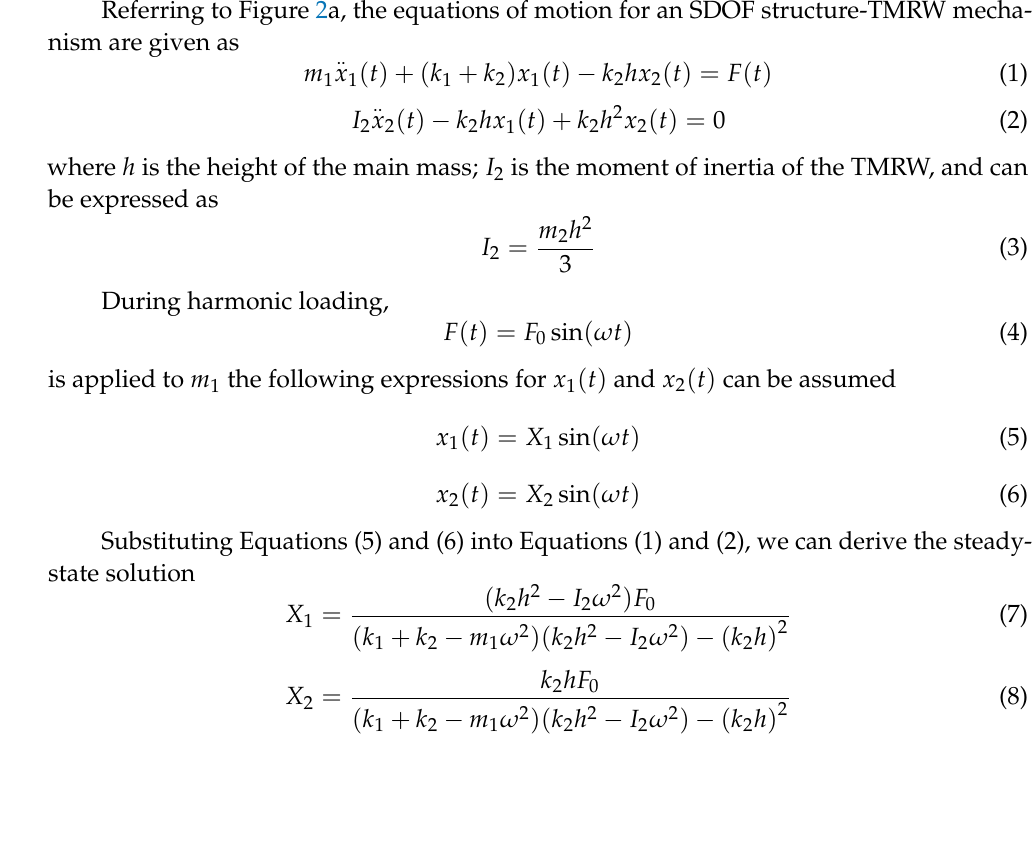
Figure 2. Schematic model of TMRW: ( a ) TMRW-1 model; ( b ) TMRW-2 model; ( c ) TMRW-3 model.